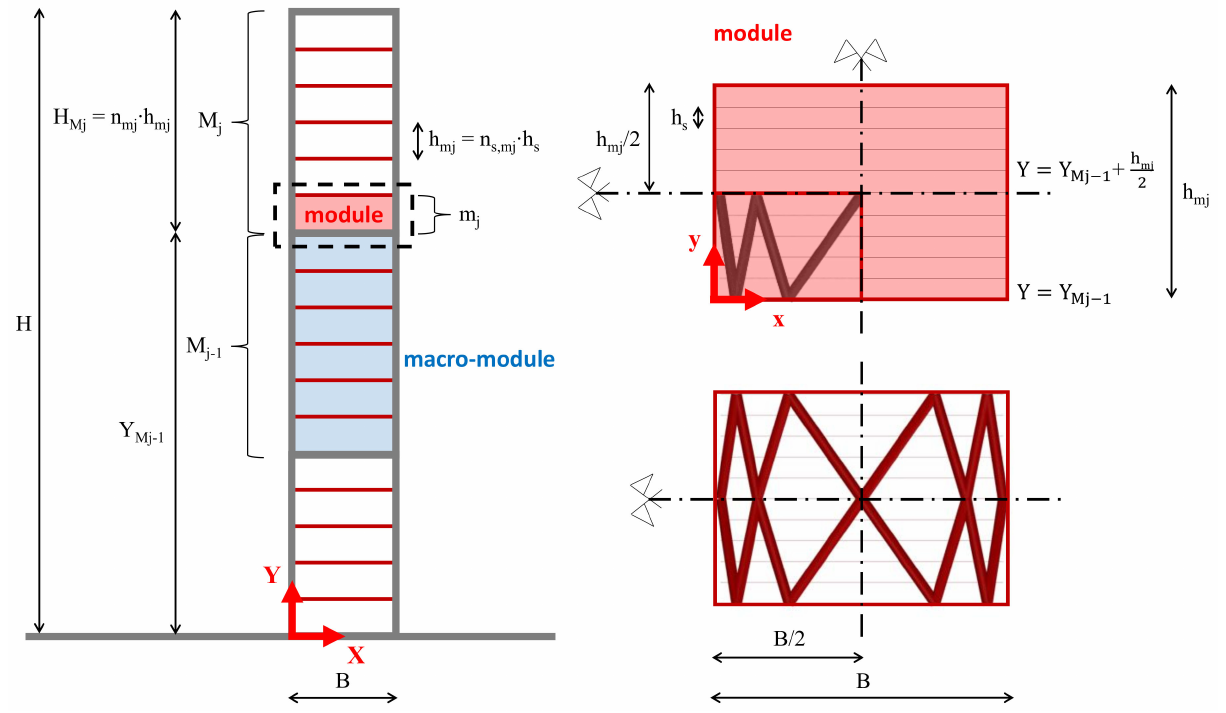
Figure 3. Schematic representation of the